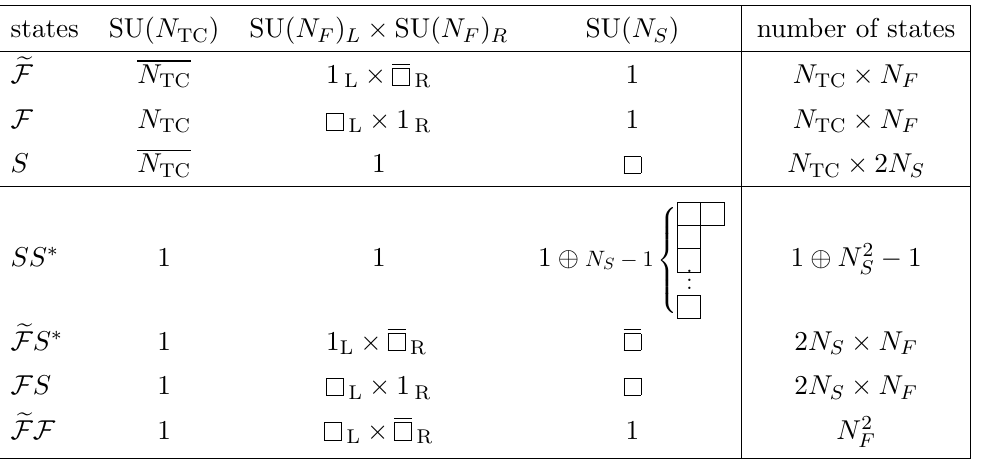
Table 3 . Fundamental and composite matter (cid:12)elds for G TC = SU( N TC ). N F ( N S ) is the number of TC-fermions